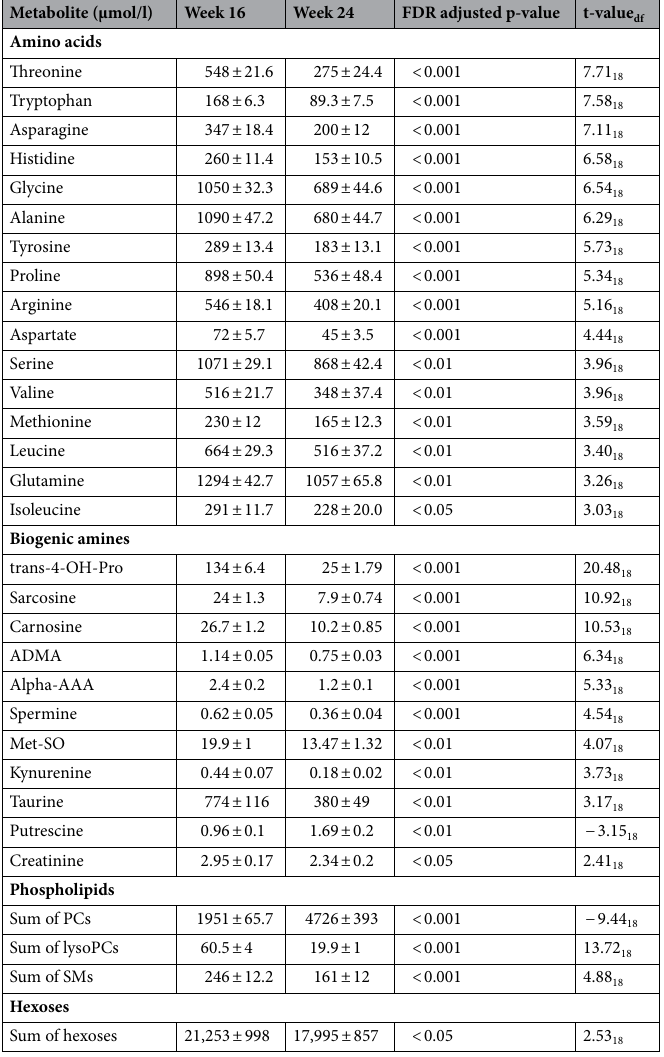
Table 3. LSL hens—week 16 to 24: differential metabolite concentrations in plasma according to FDR adjusted p-value from t-student’s test. Comparison between LSL hens at 16 (n = 10) and 24 (n = 10) weeks of age. Values are showed as means ± SEM. ADMA asymmetric dimethylarginine, Alpha-AAA alpha-aminoadipic acid, Met-SO methionine sulfoxide, PC glycerophosphatidylcholines, SM sphingomyelins. FDR-adjusted p < 0.05 as significance level was used. t-value indicates the ratio between the difference between and within both groups. Degrees of freedom (df) are shown in the figure as subscript of